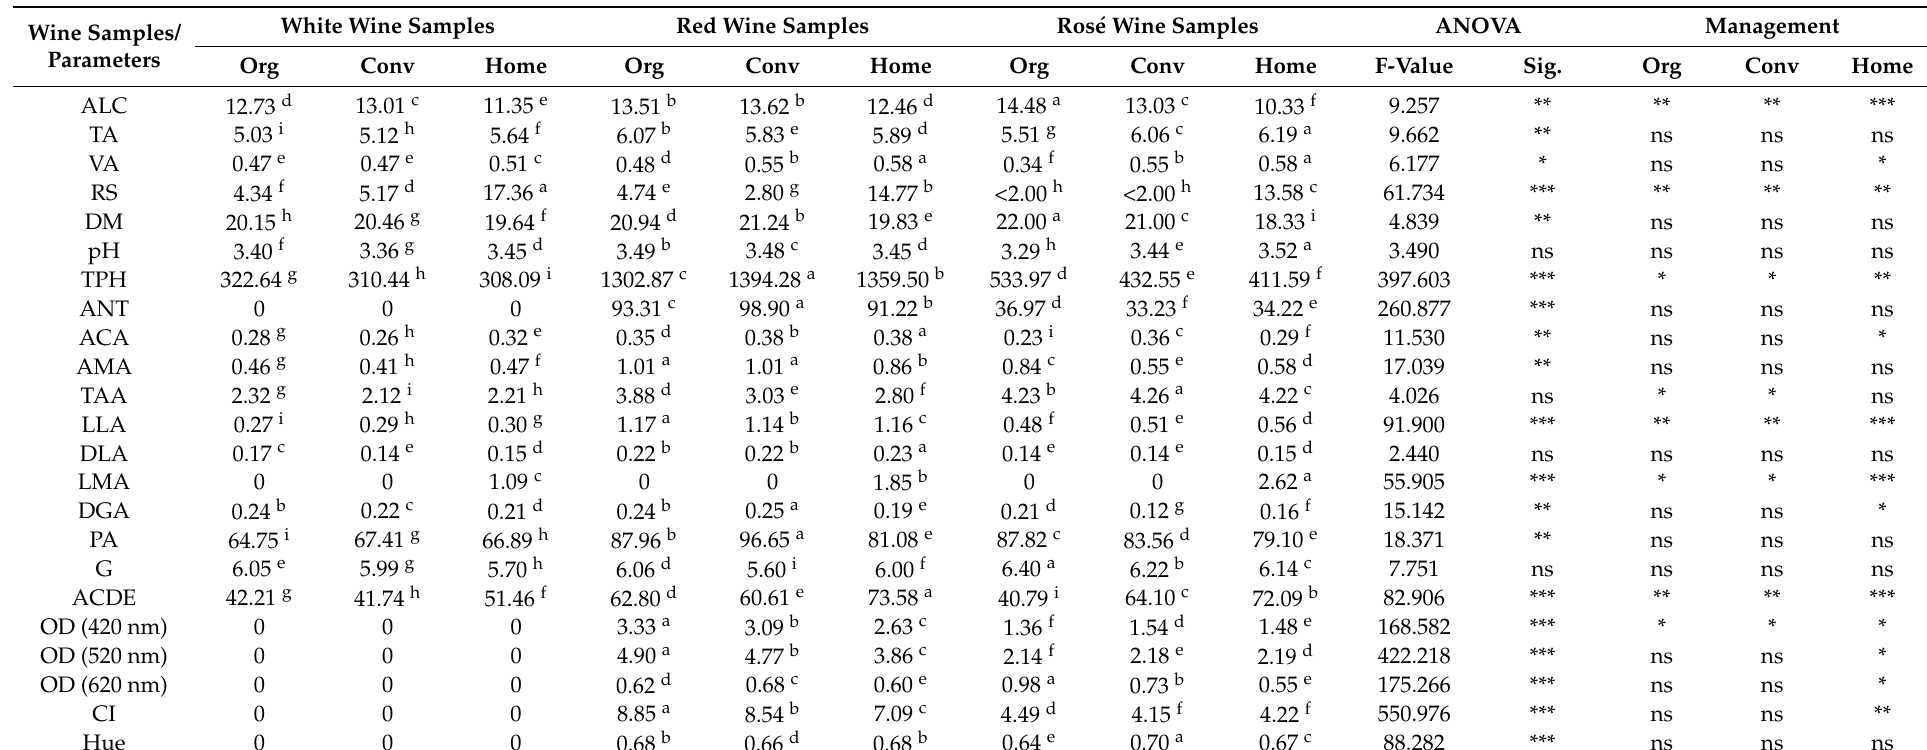
Table 1. Physicochemical composition of wine samples by wine